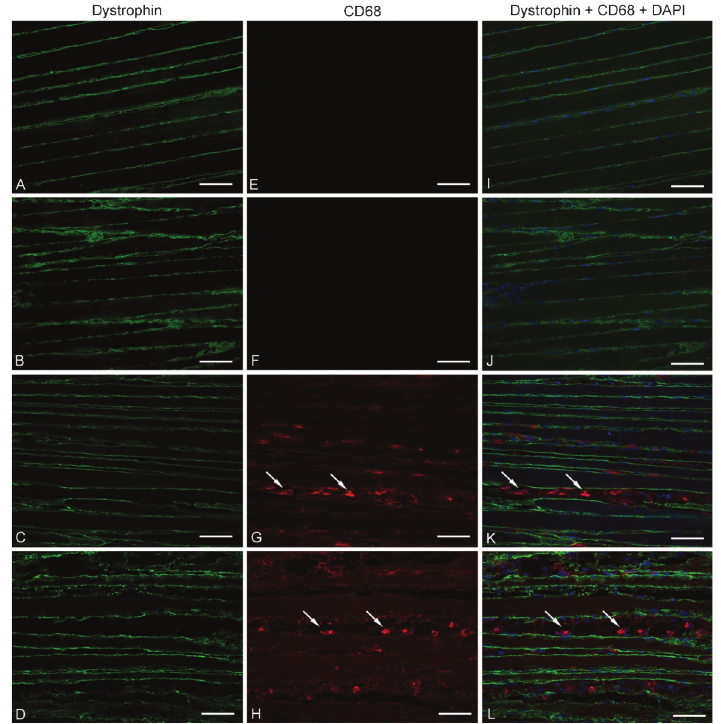
Figure 2. Photomicrographs of the soleus muscle of the animals in groups C (Immob) , I, IF (1) , and IS (1) , A - L : Longitudinal sections immu- nolabeled with rabbit polyclonal anti-dystrophin (green fluorescence) and mouse monoclonal [ED1] anti-CD68 (red fluorescence) antibodies, nuclear fluorescent staining defined by DAPI (blue fluorescence). A [C (Immob) ]: Staining for dystrophin without changes. B (I): Staining thickness. C [IF (1) ] and D [IS (1) ]: Larger number of fibers in the image site, staining thickness, sarcolemmal undulations. E [C (Immob) ] and F (I): No staining of CD68 protein. G [IF (1) ] and H [IS (1) ]: Immunofluorescent staining of the CD68 protein expressed in the cellular membrane of macrophages (arrows). I [C (Immob) ] and J (I): Merged images of dystrophin and DAPI. K [IF (1) ] and L [IS (1) ]: Merged images of dystrophin, CD68, and DAPI. Observe the location of macrophages and their respective nuclei (arrows). See Figure 1 legend for explanation of abbreviations. Scale bars: 50 m